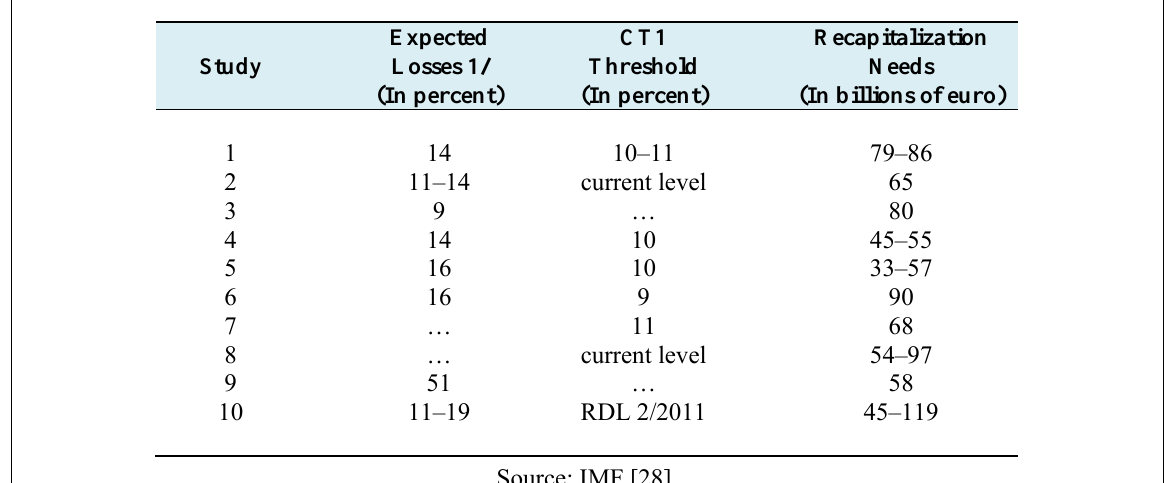
Box Table 1. Spain: Market Estimates of Bank Recapitalization Needs with Associated Hurdle